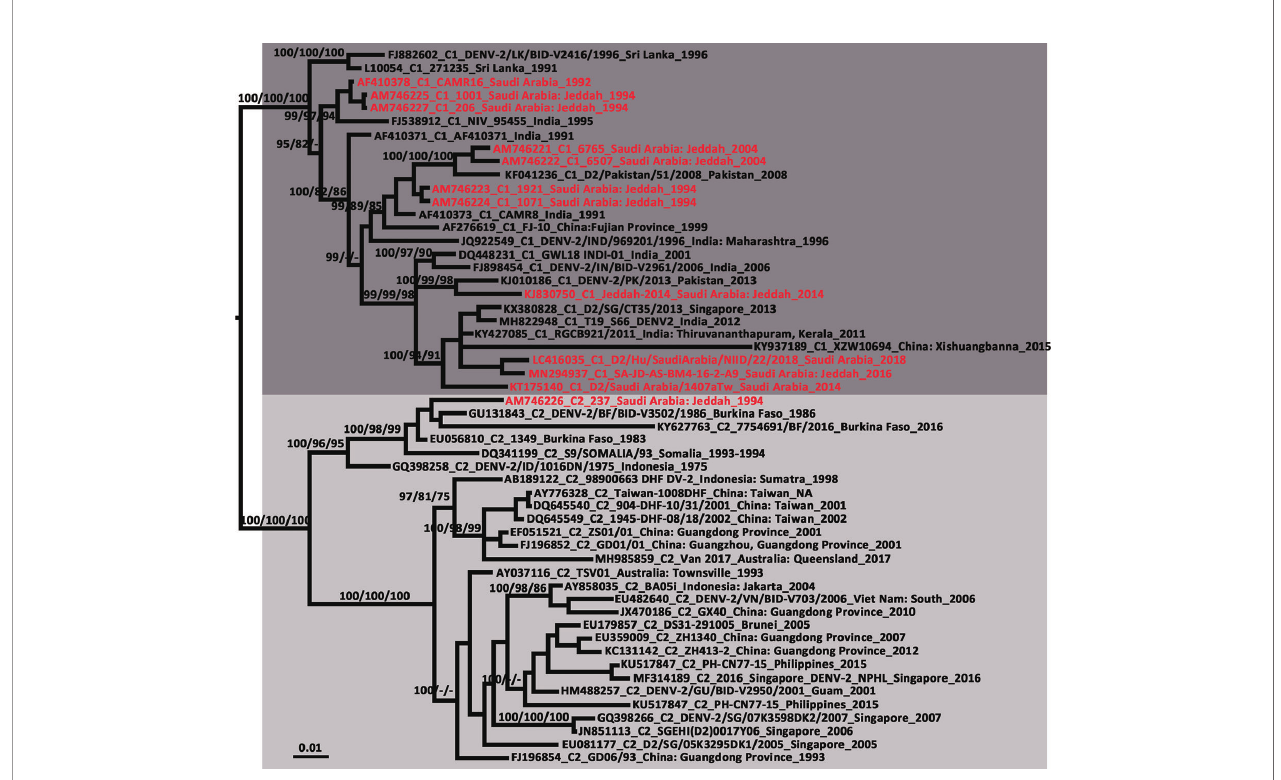
FIGURE 4 | Phylogenetic tree generated by Bayesian analysis of dengue virus 2 (DENV-2) Cosmopolitan genotype complete envelope gene. The GenBank accession number, virus sub-genotype, strain, collection country and year are noted. The DENV-2 sequences from Saudi Arabia are marked in red. Bootstrap values (1,000 replicates, not shown for less than 75%) of Bayesian analyses, maximum likelihood and neighbor-joining are shown above/below the main lineages. The scale-bar indicates 0.01 substitutions per site. Dark gray and light gray indicate DENV-2 Cosmopolitan 1 sub-genotype and DENV-2 Cosmopolitan 2 sub-genotype, respectively. C1, Cosmopolitan 1 sub-genotype; C2, Cosmopolitan 2